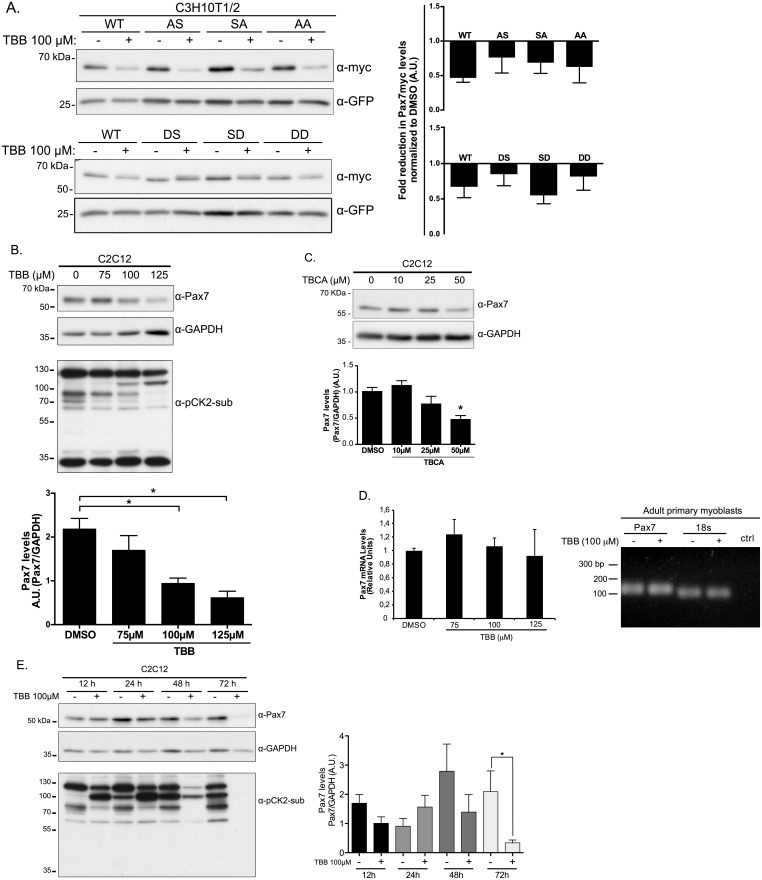
CK2 regulates Pax7 stability in proliferating myoblasts.(A) C3H10T1/2 cells transfected with myc-Pax7-WT or mutants were treated with DMSO or 100 μM of CK2 inhibitor (TBB) for 6 hours prior to lysis and Western Blot analysis. GFP was used as transfection/loading control. Right panels show quantification of fold reduction in myc-Pax7 levels (myc/GFP) for each treatment compared to vehicle (DMSO); mean±SEM, n = 5 (upper), n = 4 (lower). Pax7-DS and Pax7-DD phospho-mimetics exhibit enhanced stability upon CK2 inhibition compared to other phospho-mutants. Proliferating C2C12 cells were incubated with DMSO, TBB (B) or TBCA (C) at the indicated concentration for 6 hours. Endogenous Pax7 levels were analyzed by Western Blot using GAPDH as loading control. Anti-phospho-CK2 substrate antibody was used as a control of TBB treatment. (B)-(C), Lower panels show quantification of Pax7/GAPDH ratio in relative units; mean±SEM, n = 4; ANOVA, * p<0.05. Pax7 protein levels are significantly reduced with 125 μM TBB for 6 hours in proliferating C2C12 cells. (D) (left panel) qPCR analysis determining relative Pax7 mRNA expression upon CK2 inhibition as performed in (B). mean±SEM, n = 3. (Right panel) RT-PCR analysis of Pax7 mRNA expression upon CK2 inhibition in adult primary myoblasts (n = 3). (E) Proliferating C2C12 cells were incubated with DMSO or TBB for 12, 24, 48 and 72 hours, adding fresh doses every 24 hours. Lower panel shows quantification of fold reduction in Pax7 levels (Pax7/GAPDH) for each treatment compared to vehicle (DMSO); mean±SEM, n = 3.